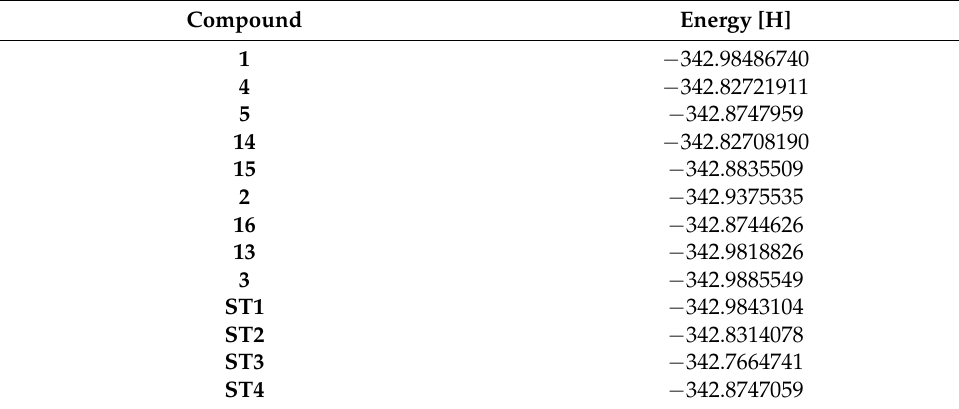
Figure 3. Dewar isomers in the photoisomerization of 2,6-dimethylpyrazine.